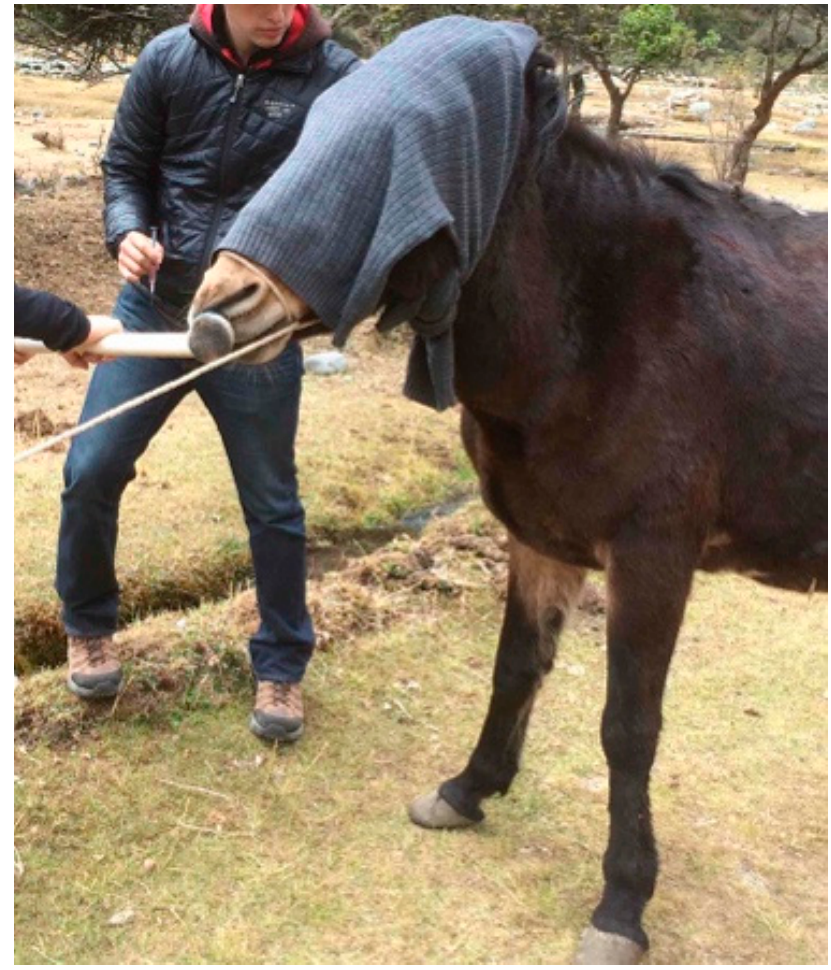
Figure 6. Judicious use of restraints may need to be applied to a fearful mule or hinny when some routine procedures such as administering an injection are performed. A blindfold, possibly in combination with a nose twitch, can help achieve calm administration of a vaccine and create less stress. This does not imply that using restraints is preferable to slow, careful training in more ideal circumstances.